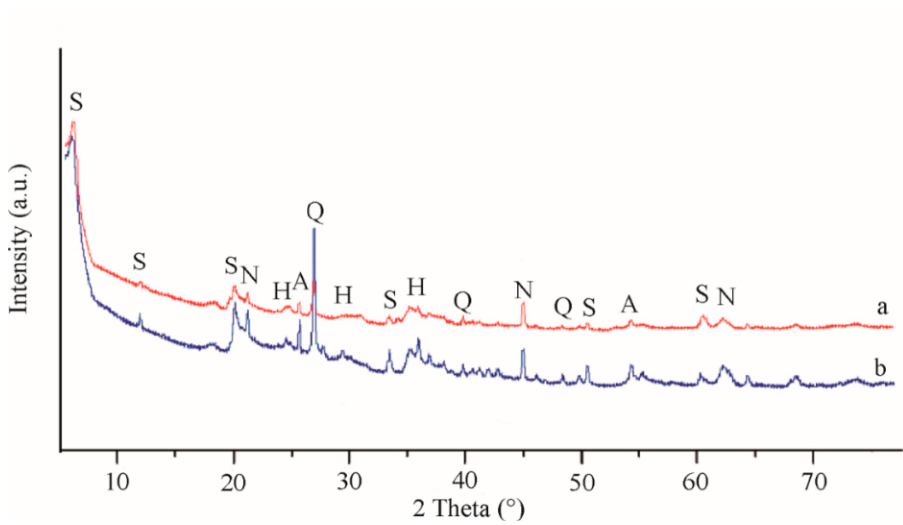
Figure 5. X-ray diffraction patterns of the studied saponite samples—( a ) raw saponite and ( b ) acid- treated saponite. S,saponite; Q, quartz; N, nontronite; H, hematite; and A, anatase.